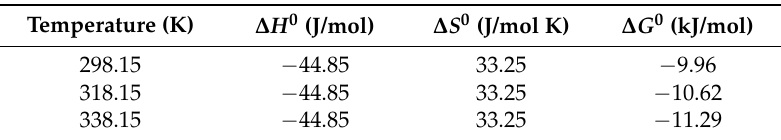
Table 2. Thermodynamic